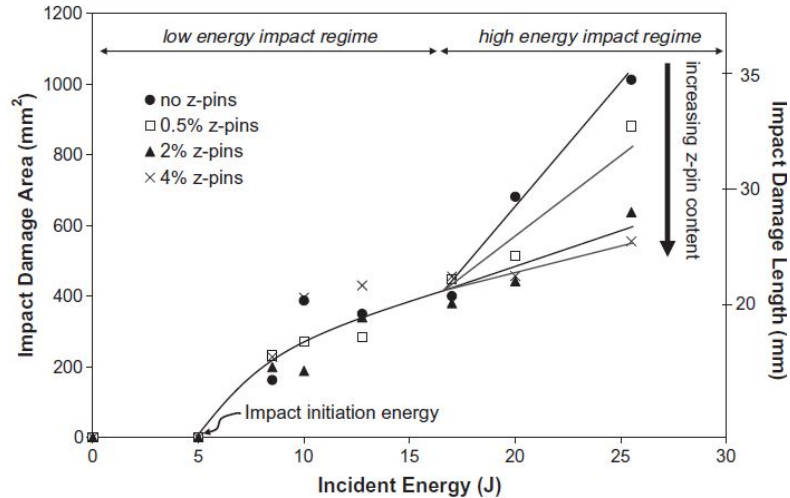
Figure 73. Effect of z-Pin content and impact energy level on impact damage area (CFRP z-Pins, d = 0.28 mm, [0/±45/90] pre-preg) [7].